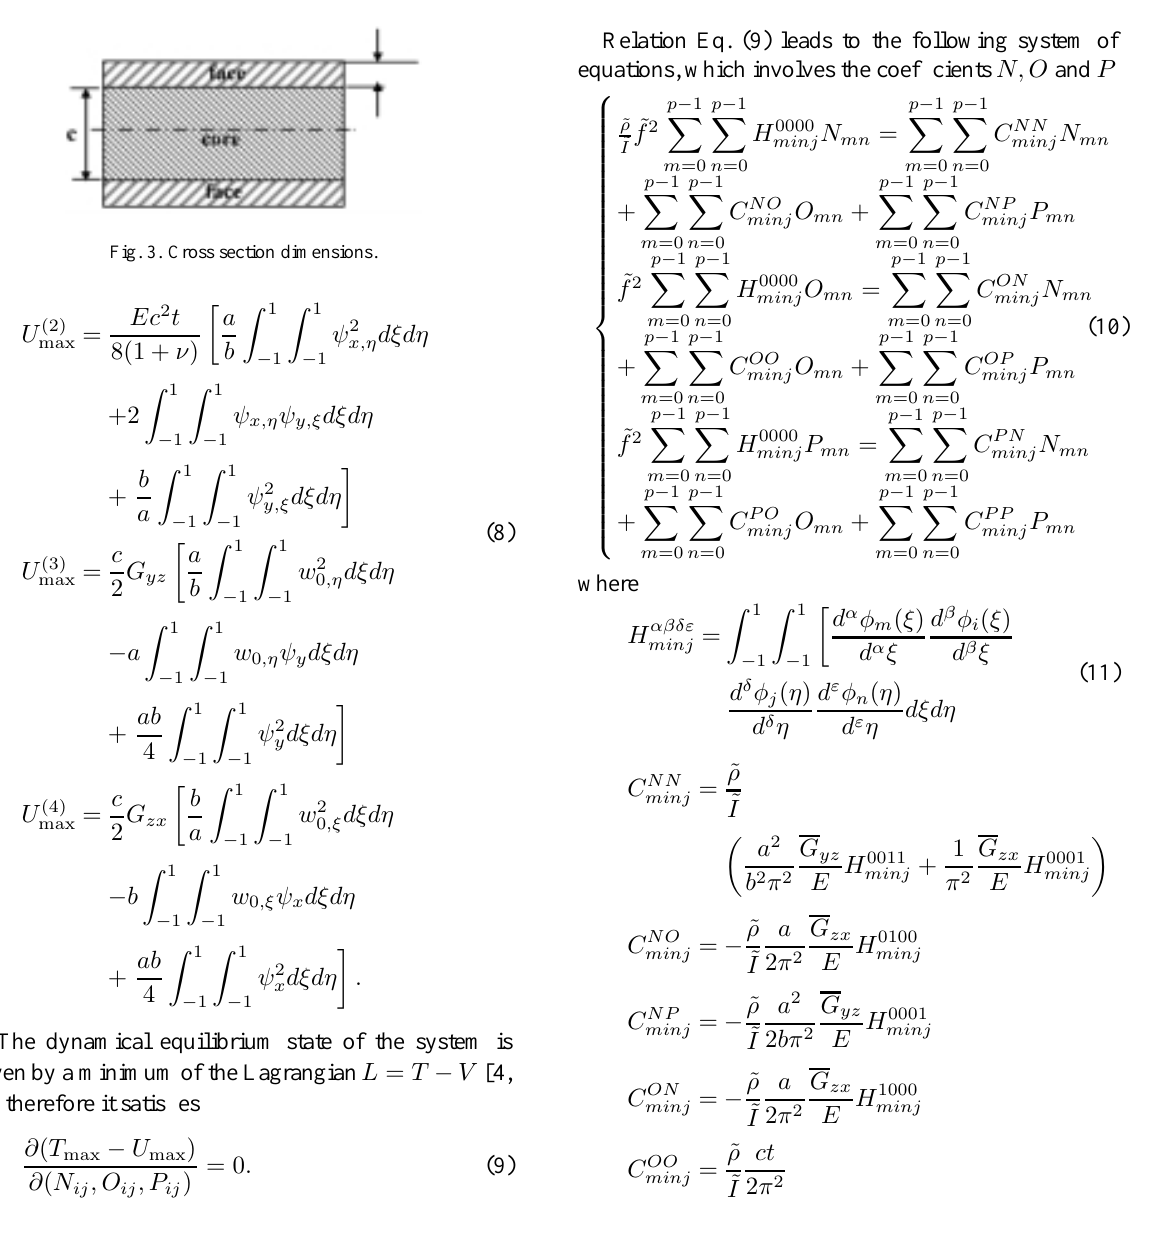
Fig. 2. Experimental configuration.